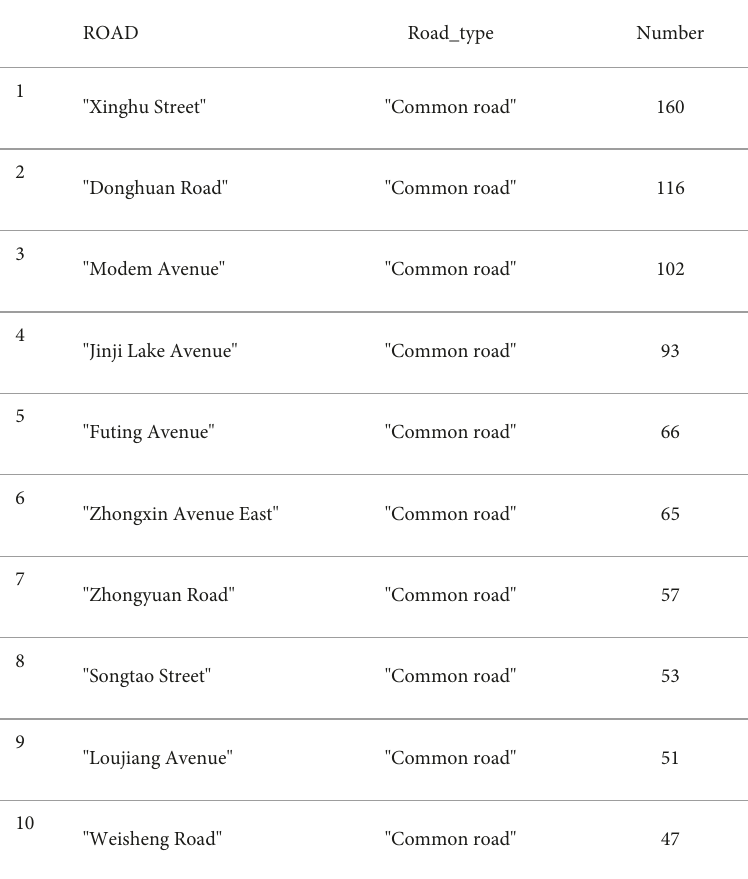
Figure 10: Number of accidents per road—top 10 roads.